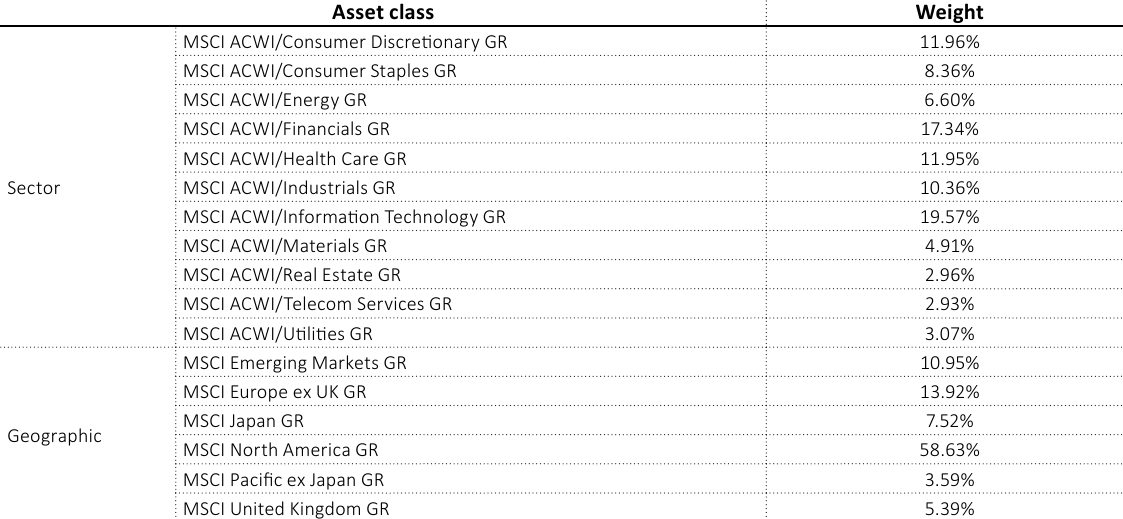
Table 1. Weights of the sectorial and geographic segmentation of the MSCI ACWI Asset class Weight